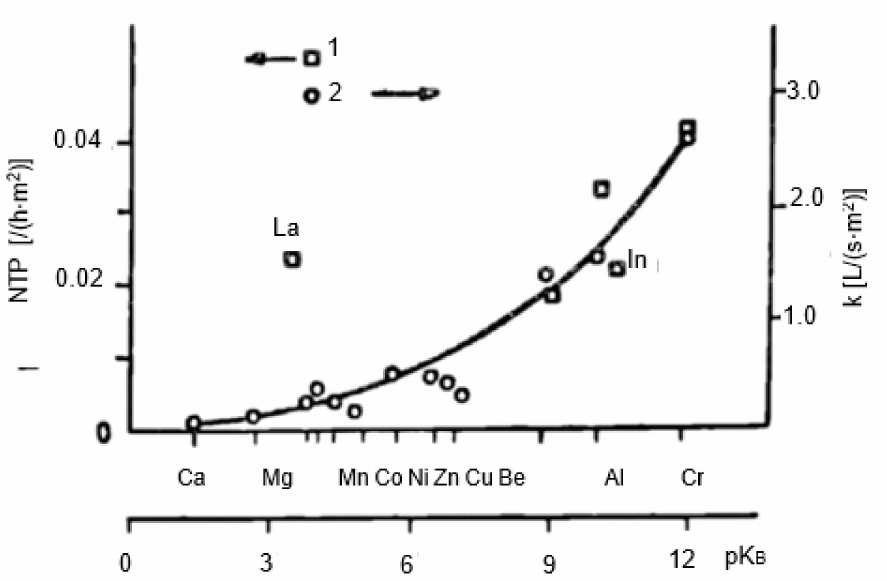
Figure 16. Activity vs. reducibility: (1) Pernicone’s data ( (cid:3) ) [NL/h/m 2 ]; (2) Kolovertnov’s data (o), k [mL/s/m 2 ], [44]. Reproduced from [44] copyright (1968) with permission from copyright